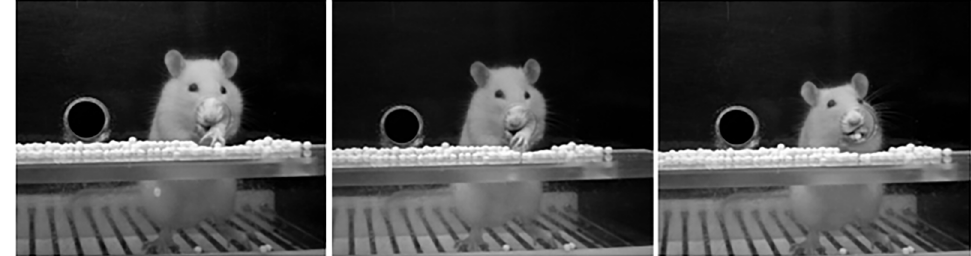
Figure 12. Paw-reaching-for-food task in the test cage. Three consecutive photographs showing a rat in the test cage performing a successful response in the paw-reaching test during the training in the pre-surgical phase. The design of the test cage prevents the use of the tongue to retrieve food pellets or to rake the pellets.